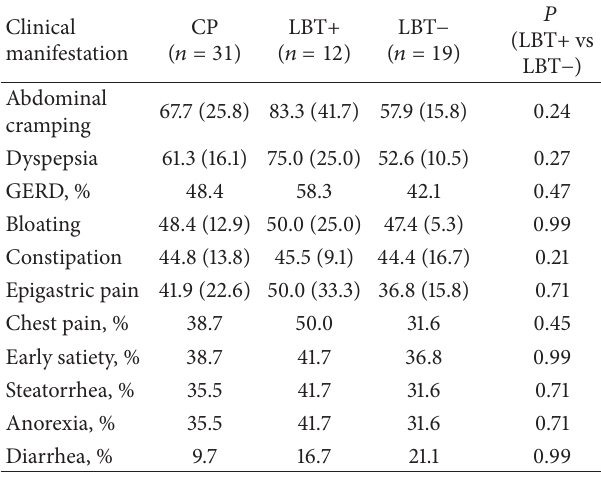
Table 2: Clinical manifestations in patients with chronic pancreati-